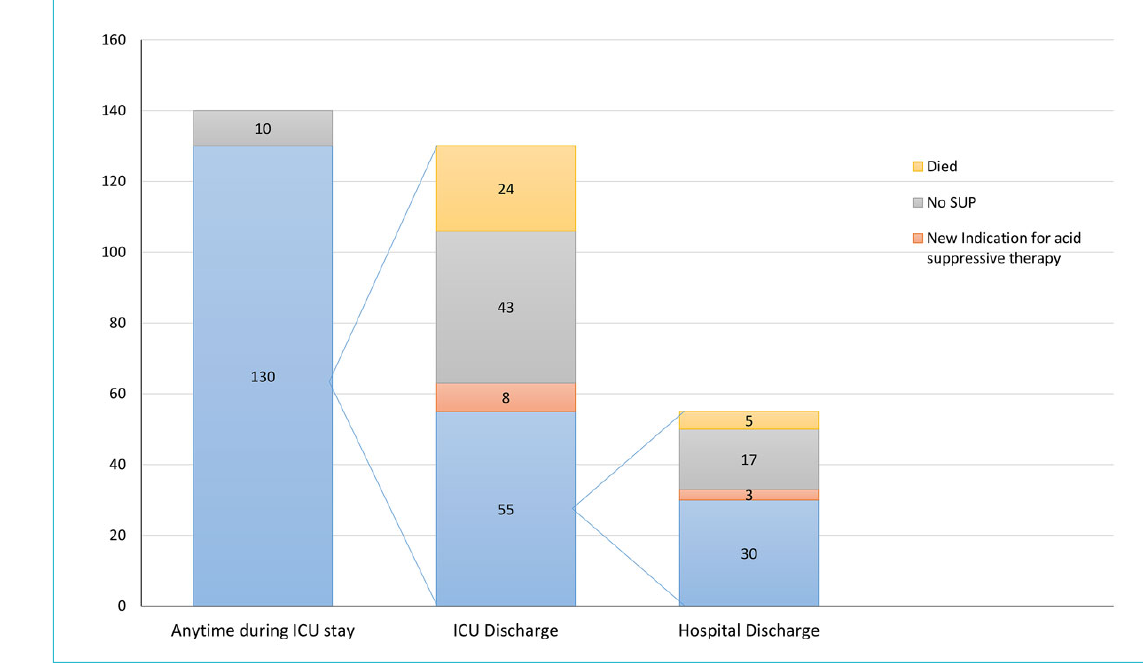
Figure 4: Adequacy of acid-suppressive therapy on ward stay and hospital